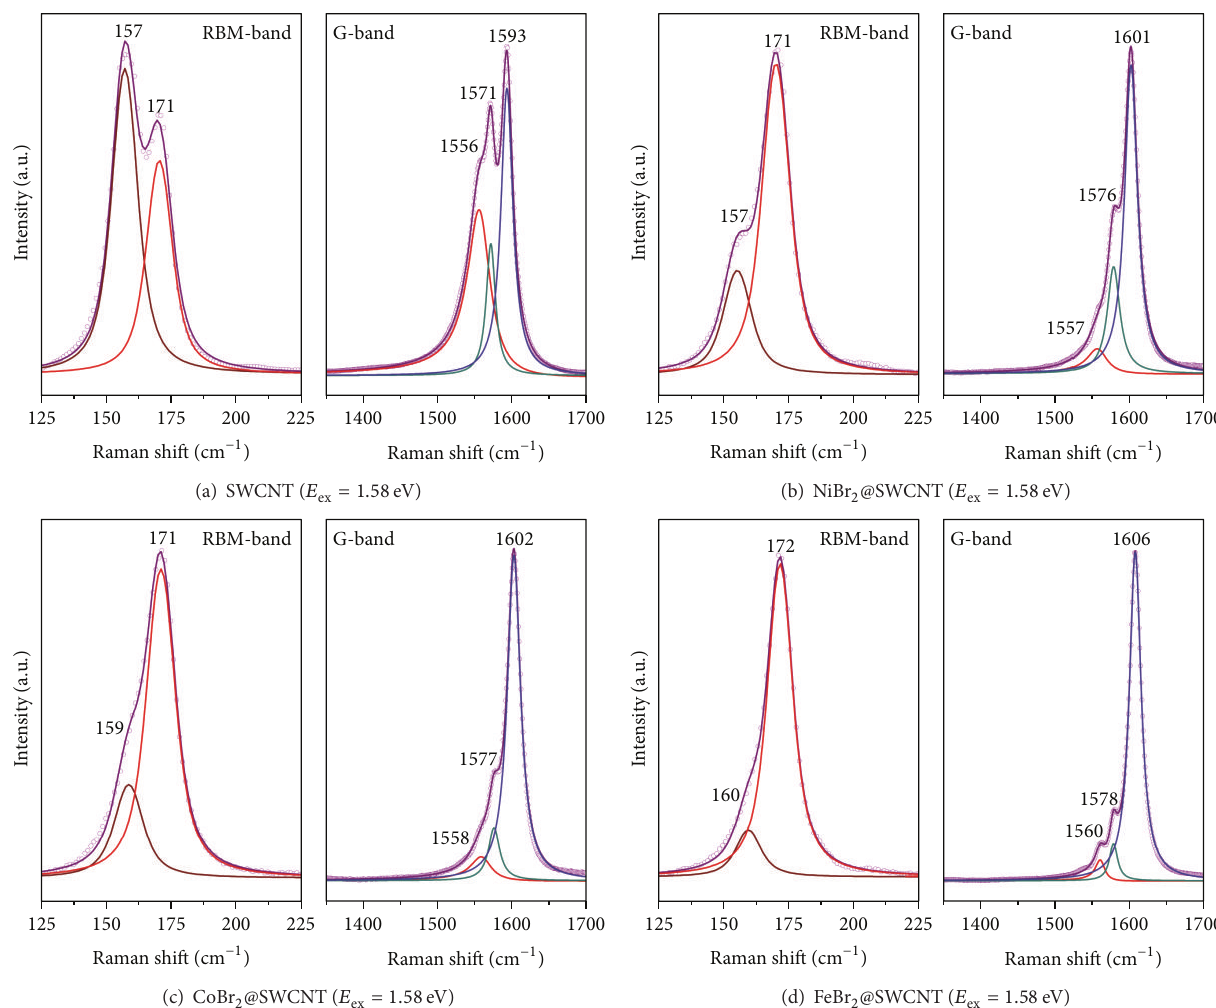
Figure 2: The fitting of the RBM- and G-bands of the Raman spectra of the pristine SWCNTs (a), NiBr 2 @SWCNT (b), CoBr 2 @SWCNT (c), andFeBr 2 @SWCNT(d)samplesacquiredatalaserenergyof1.58 eV.TheRBM-bandsincludetwocomponents,whichbelongtothenanotubes of different diameters. The G-bands include one component of metallic SWCNTs (G − at the lowest frequencies) and two components of at lower and G + at higher semiconducting SWCNTs (G + TO LO